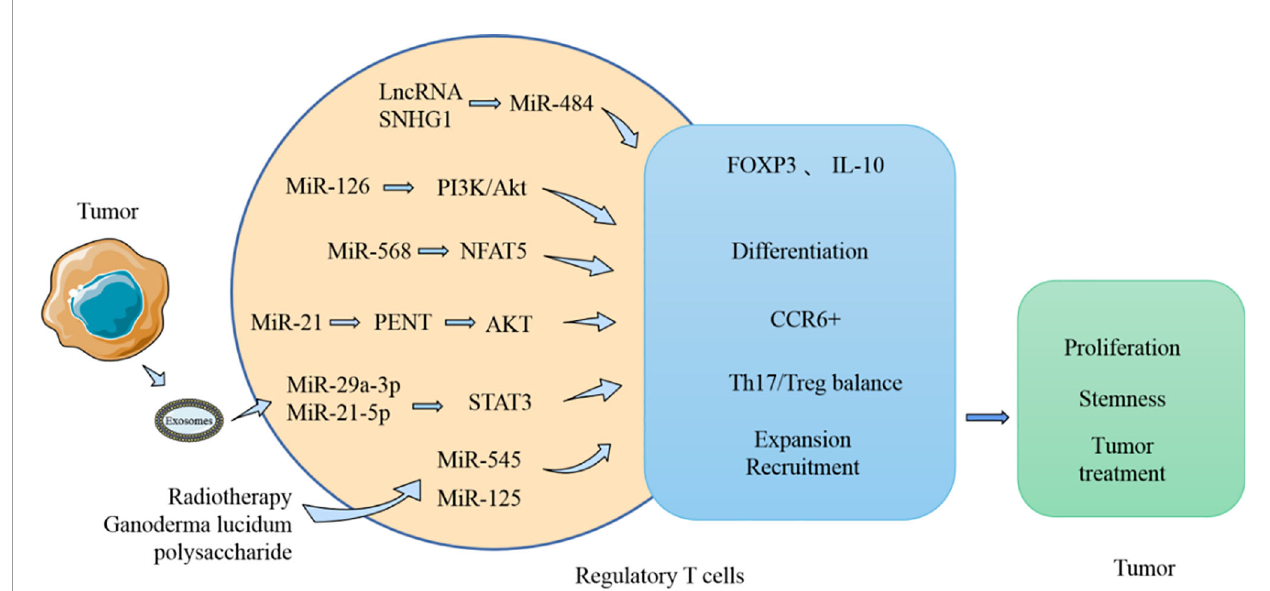
FIGURE 5 | MiRNA in fl uences the tumor process by modulating Treg. MiRNA participates in the regulation of the production and function of Treg in TME. MiRNA can affect the expression of FOXP3 and IL-10, which in turn affects the activity of Treg on tumor. Moreover, the Th17/Treg balance regulated by miRNA can also in fl uence tumor